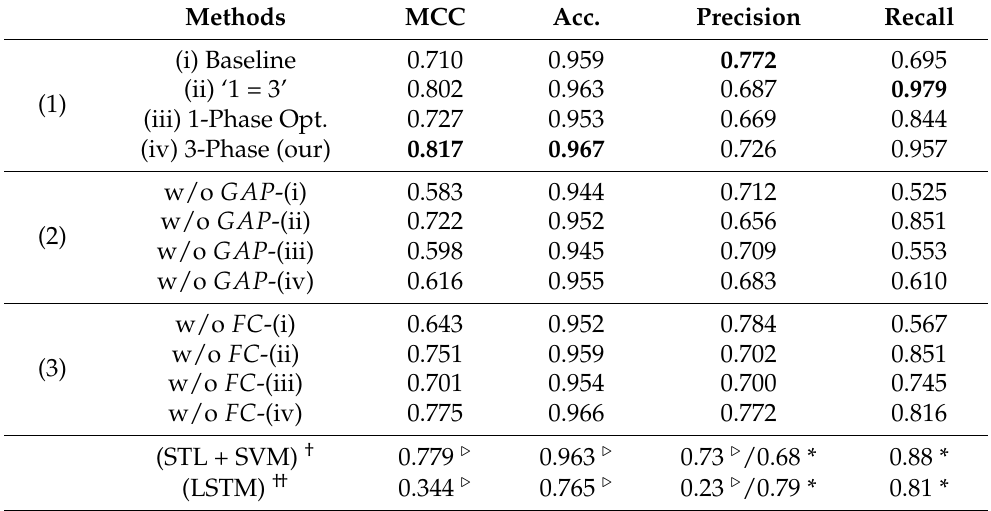
Table 2. Ablation study and impact of the decision rules on the proposed model with N p = 200 and w =